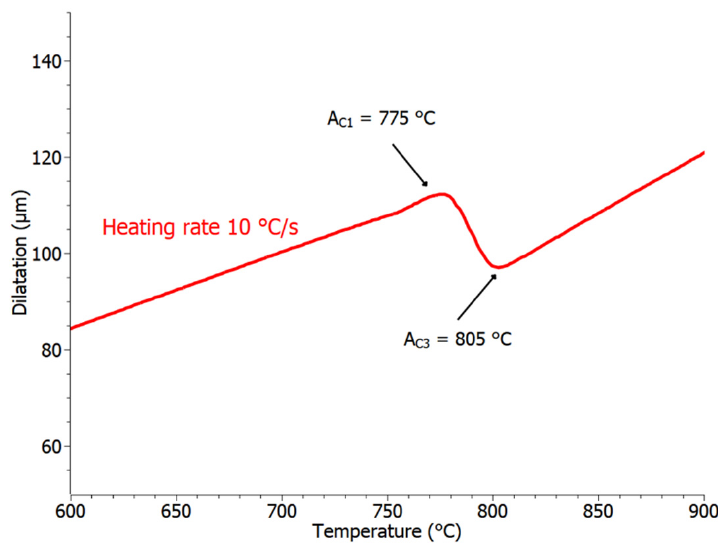
Figure 5. Determination of transformation temperatures at 10 °C/s heating rate.